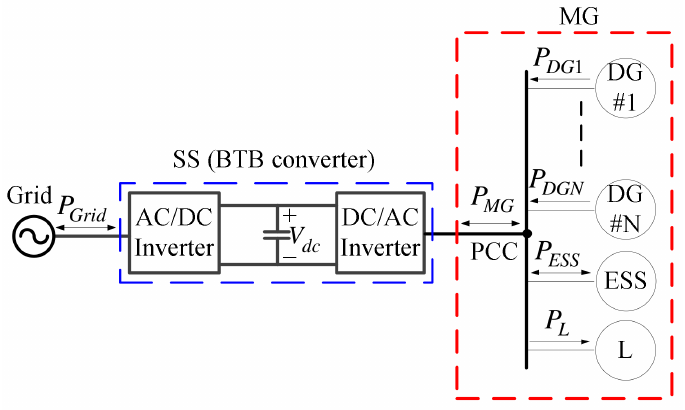
Figure 2. A grid-connected MG with a BTB inverter-based